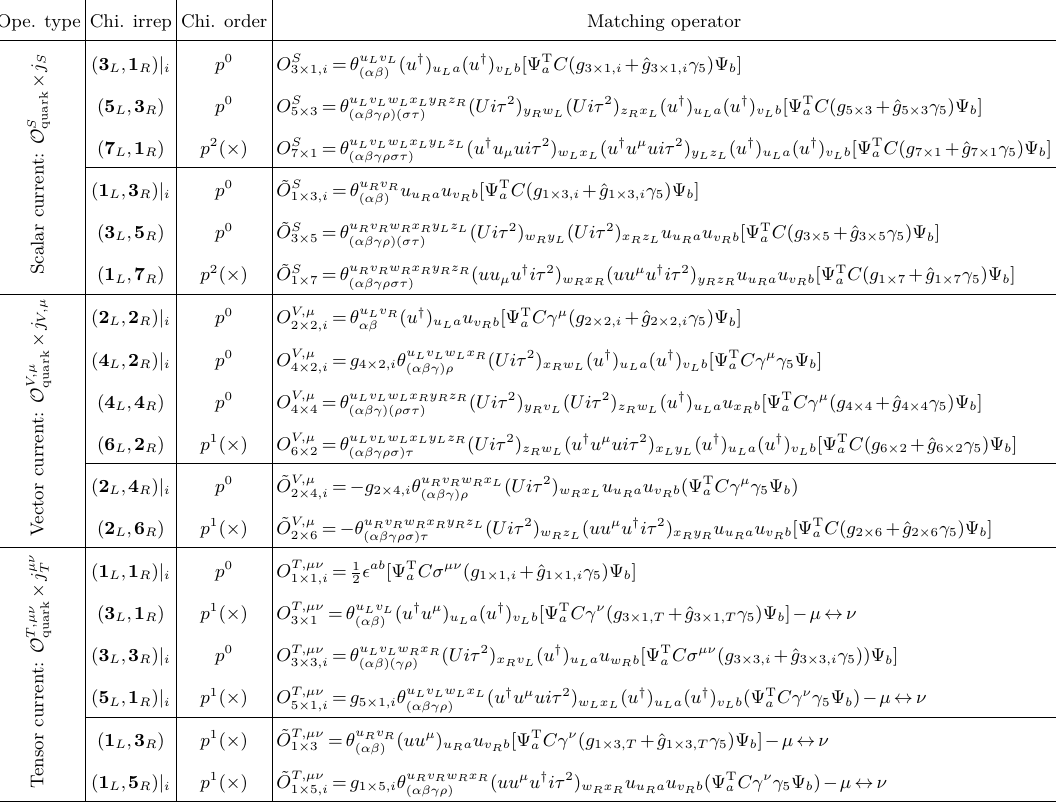
Table 8 . The leading order chiral matching of the chiral irrep six-quark part in our assumed framework without including terms containing nucleon derivatives. Where in the third column we show the leading chiral order of each matched operator, and the crosses ( × ) behind p 1 , 2 indicate the matched operators cannot contribute to the leading order dim-6 interactions in eq. (2.5)